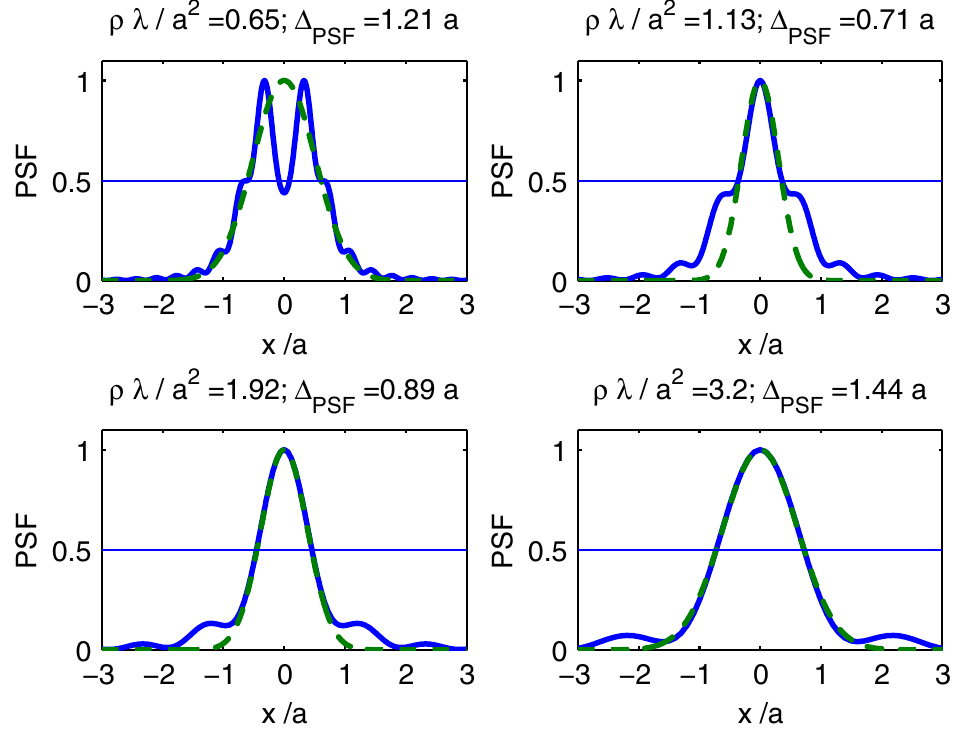
FIG. 7. (Color) Normalized PSF and comparison with a Gaussian of the same FWHM.